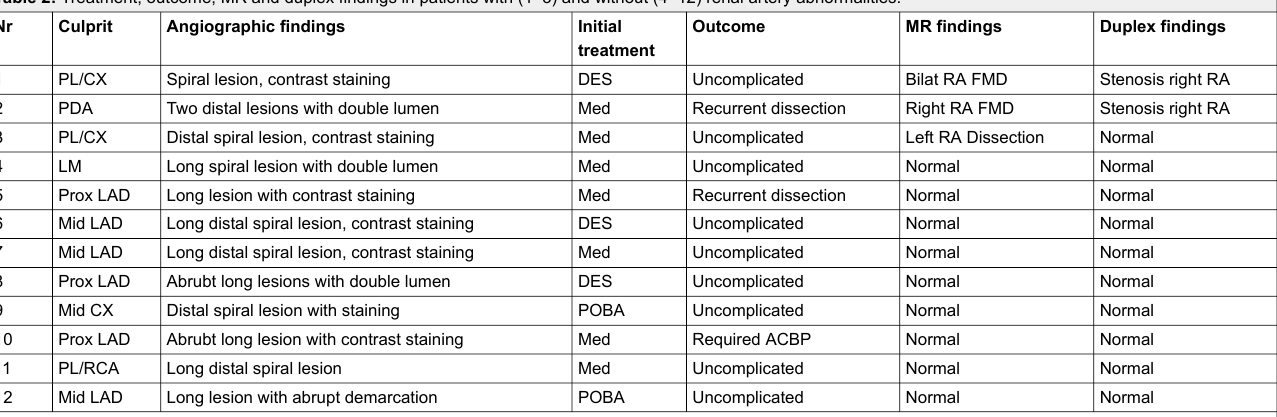
Table 2: Treatment, outcome, MR and duplex findings in patients with (1–3) and without (4–12) renal artery abnormalities. Nr